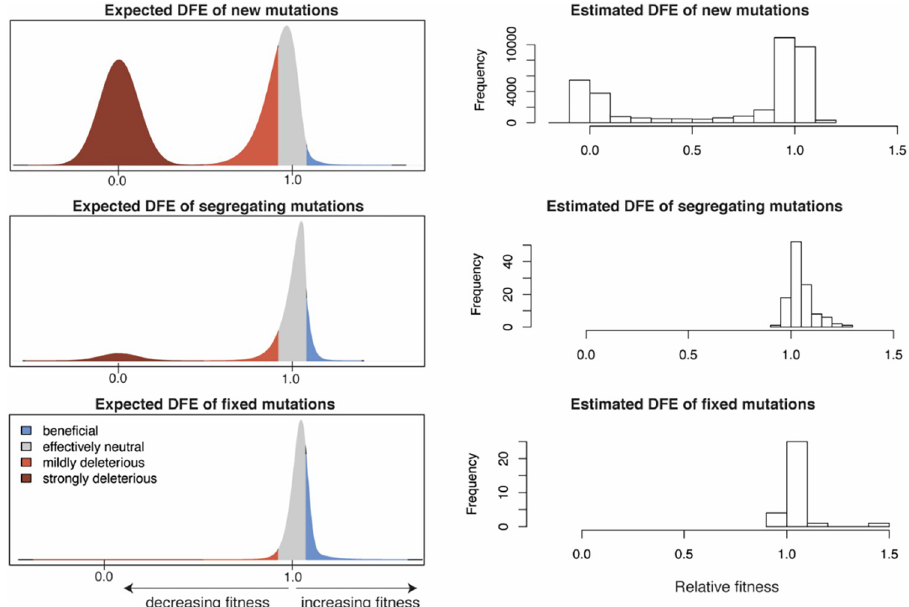
Fig 2. The expected and estimated distributions of fitness effects (DFE) of mutations. Left panels: a hypothetical expected DFE of new, segregating, and fixed mutations, reflecting the effects of selection at each stage. Effectively neutral mutations are shown in gray, beneficial mutations in blue, and deleterious mutation in shades of red. Right panels: the DFE of new, segregating, and fixed amino acid variants in SARS-CoV-2 as recently estimated by Flynn and colleagues [131], Kepler and colleagues [65], and Obermeyer and colleagues [132], respectively. From Flynn and colleagues, the normalized functional scores from 2 sets of biological replicates were pooled together. From Kepler and colleagues, the relative fitness of all single mutations from pre- and post-2020 studies were pooled together. From Obermeyer and colleagues, the DFE of fixed mutations was approximated by using 31 high-frequency variants (defined as those present in more than 100 lineages). Importantly, observed genomic variation will depend heavily on the underlying heterogeneity in both mutation rates and DFEs across the genome, among other factors [133].